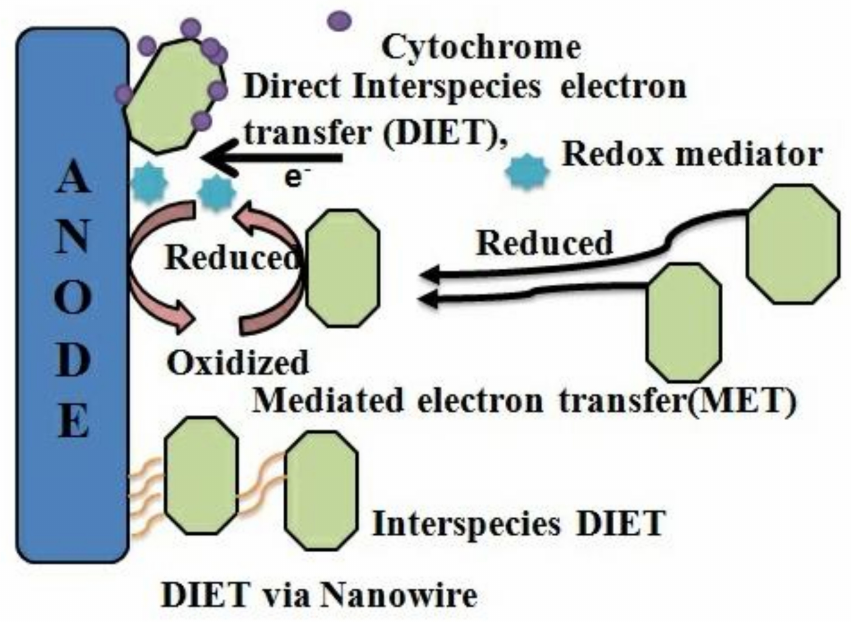
Figure 5. Interaction of microbe-electrode with electron mediators showing direct interspecies electron transfer depicting the electron transfer by cytochromes and enzymatic electron transfer